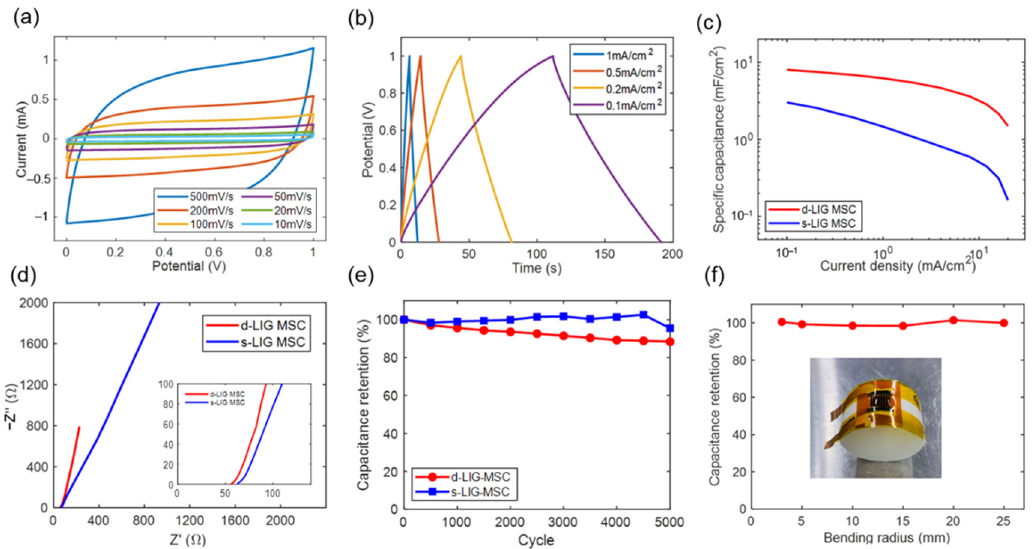
Figure 5. Electrochemical characteristics of the s-LIG-MSC and the d-LIG-MSC. ( a ) Cyclic voltammetry (CV) and ( b ) galvanostatic charging/discharging (CC) curves of the d-LIG-MSC at various charging rates. ( c ) Plot of capacitance versus current density for the s-LIG-MSC and the d-LIG-MSC. ( d ) EIS curves for the s-LIG-MSC and d-LIG-MSC. Retention of capacitance with ( e ) cyclic galvanostatic charging/discharging and ( f ) bending at various radii for the d-LIG-MSC. The d-LIG-MSC clearly exhibited higher specific capacitance than s-LIG-MSC. The CC testing